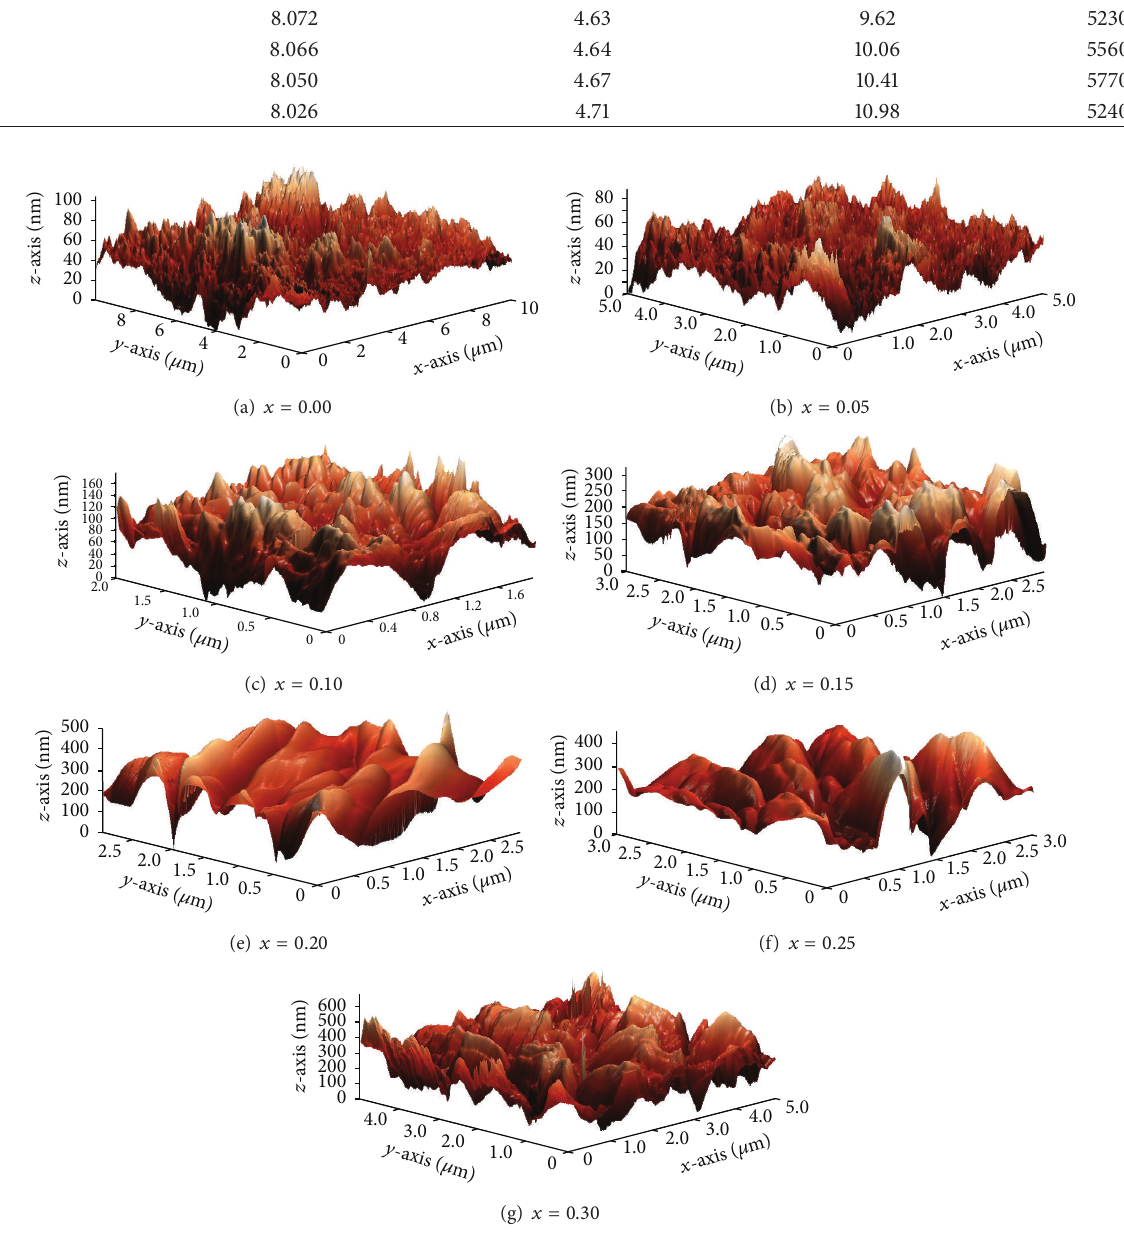
Figure 4: AFM images of Ca 𝑥 Zn (1−𝑥) Al 2 O 4 thin films.